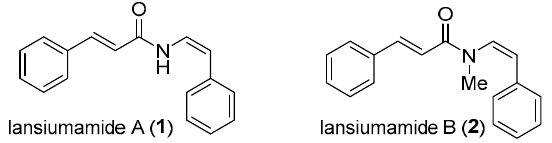
Figure 2. Molecular structure of lansiumamides A and B.